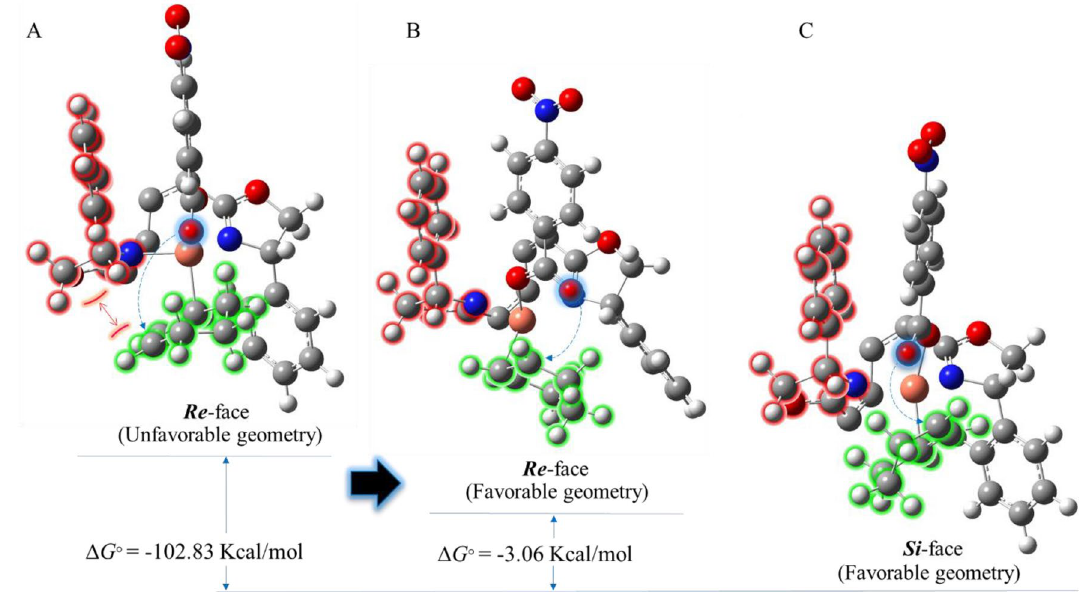
Figure 7. Steric hindrance and Gibbs free energies of the Si -face and Re -face of the key reaction intermediate containing cyclohexene reactant. To better visibility, some atoms of biphenyl backbone are not shown.